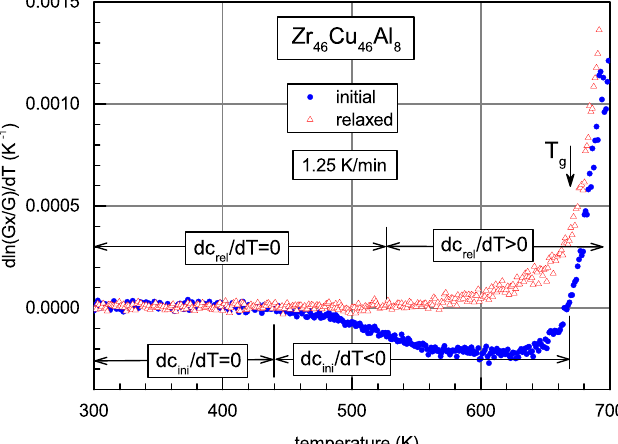
ln G x ( T ) Cu Al for glassy Zr in 46 46 8 dT G ( T )